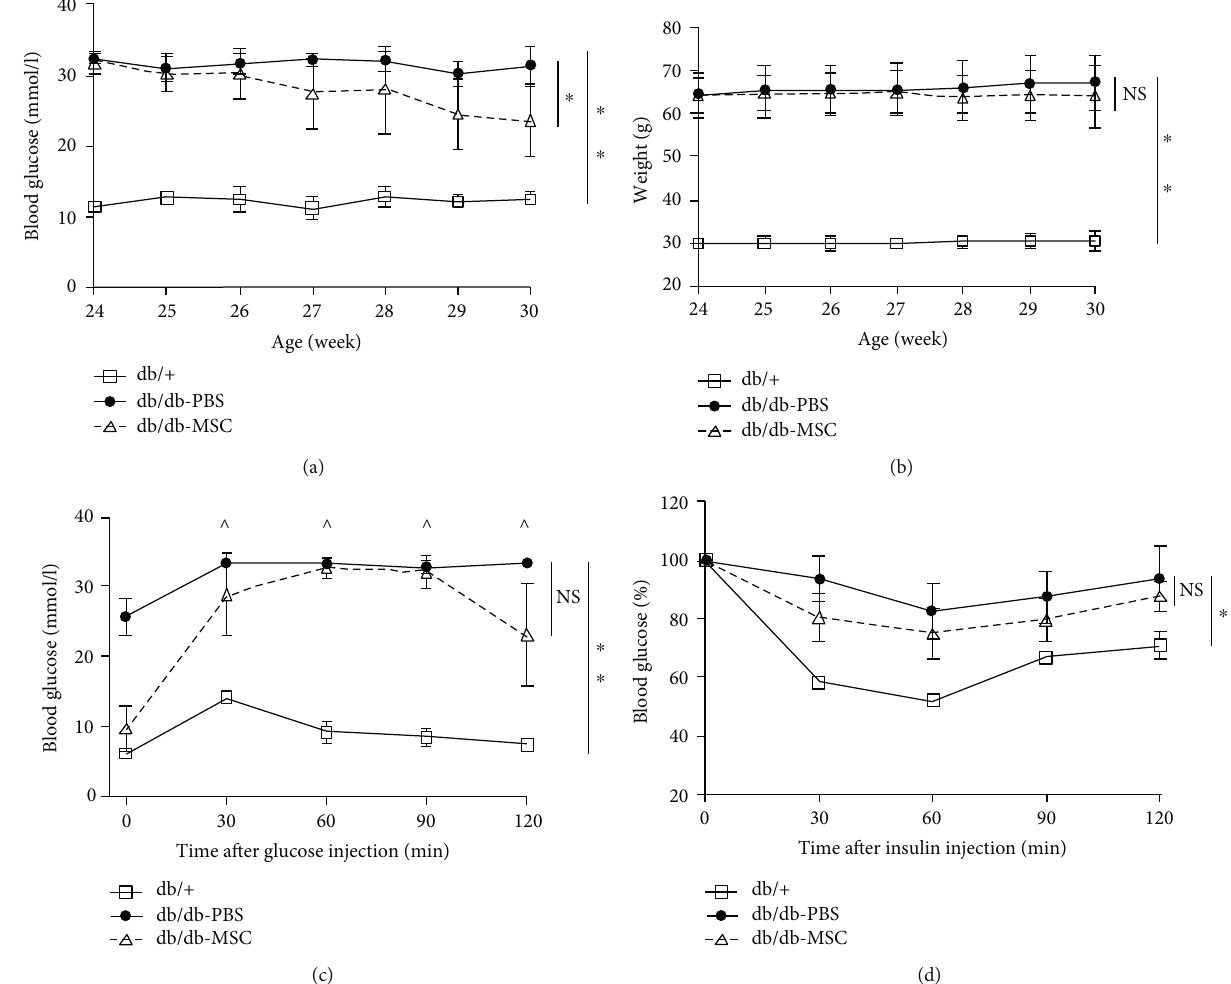
Figure 2: Human UC-MSC infusions improved glucose homeostasis. db/db mice were infused with human UC-MSCs or PBS once a week for six weeks. Blood glucose levels (a) and body weight (b) of the indicated groups were monitored once a week during the whole experiment period. (c) IPGTT was performed on the indicated groups to assess glucose tolerance. ^ indicates that the blood glucose level exceeded the maximum (33.3 mmol/l) of the glucometer. (d) IPITT was performed on the indicated groups to assess insulin tolerance, and the results were presented relative to the initial blood glucose levels. All the results are expressed as the means ± SD . n = 6 mice per group. ∗ p < 0 : 05 ; ∗∗ p < 0 : 01 . ns: not signi fi cant; IPGTT: intraperitoneal glucose tolerance tests; IPITT: intraperitoneal insulin tolerance